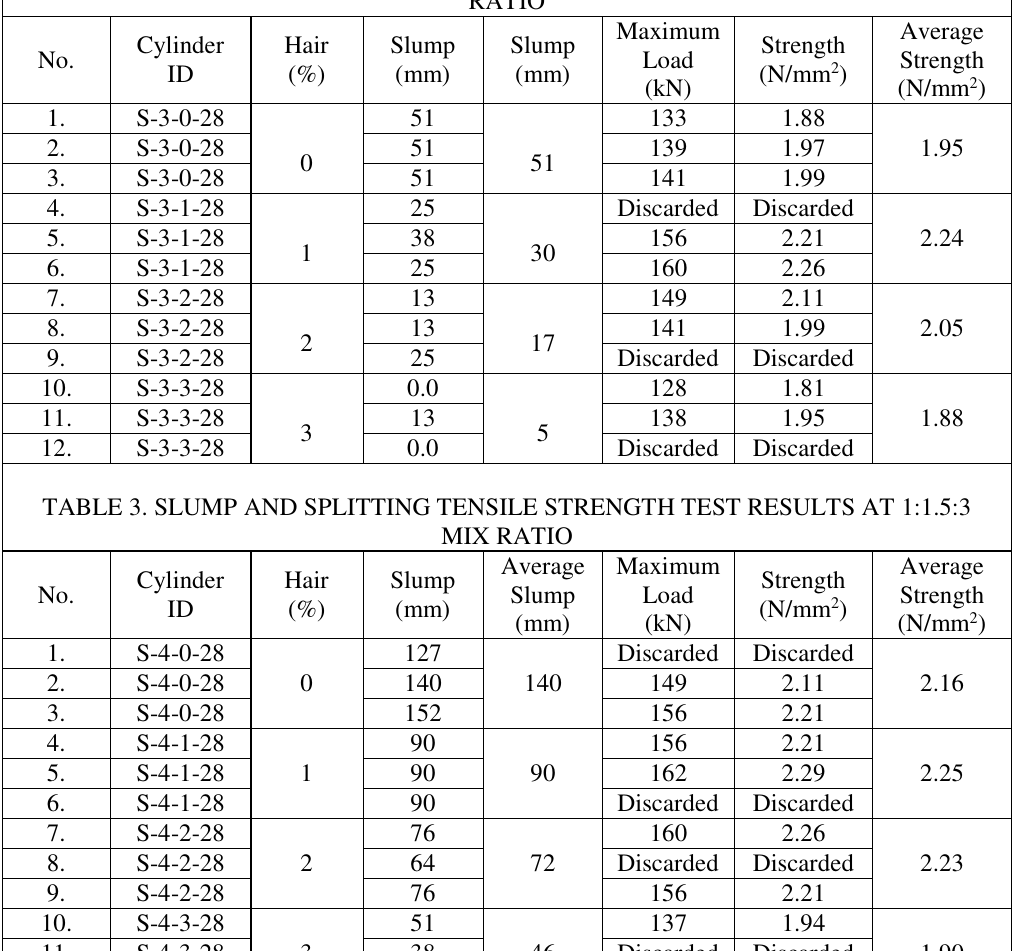
TABLE 2. SLUMP AND SPLITTING TENSILE STRENGTH TEST RESULTS AT 1:2:4 MIX